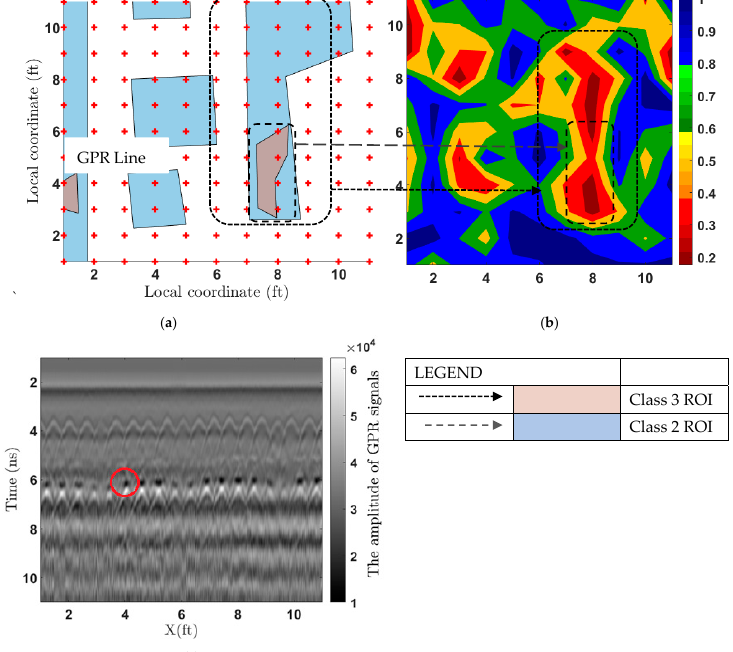
Figure 14. FR SB origin A ( a ) ground truth, ( b ) frequency approach, and ( c ) B scan of the GPR profile (local coordinate Y = 4).